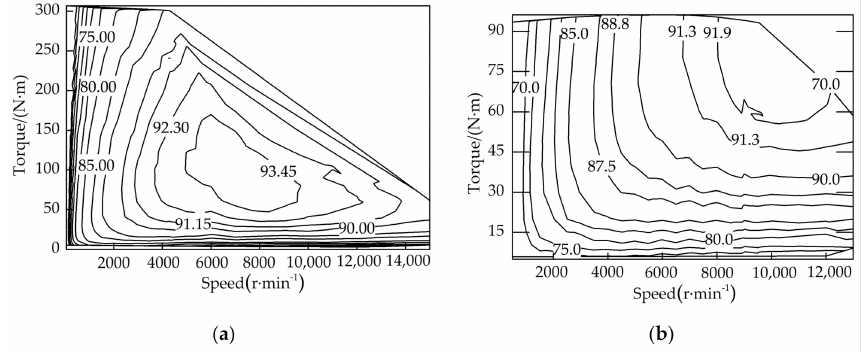
Figure 4. Motor efficiency map: ( a ) EM efficiency map; ( b ) ISG efficiency map.